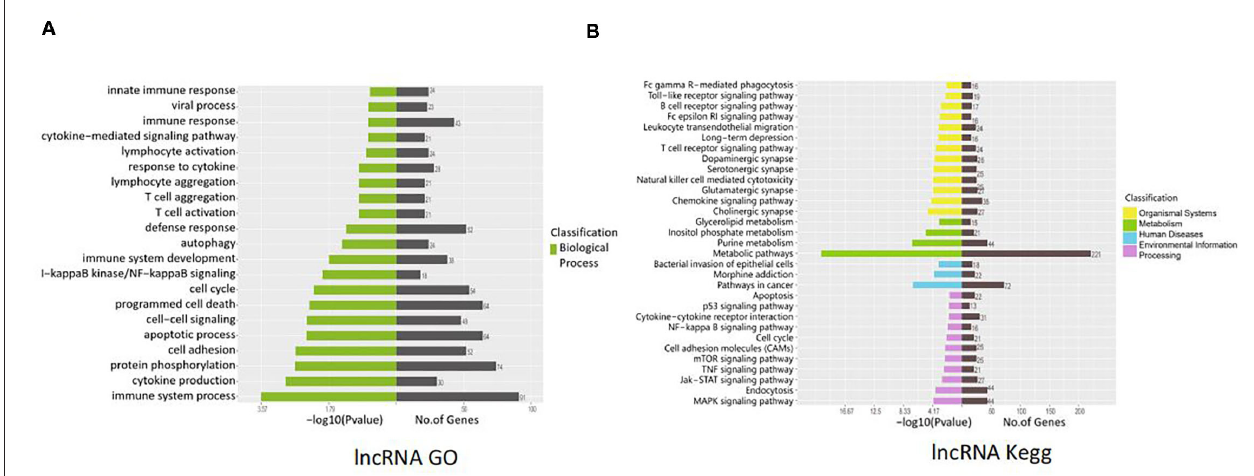
FIGURE 4 | Functional prediction of SVV-induced new lncRNAs. (A) Gene Ontology (GO) analysis of the functional annotation of differentially expressed new lncRNAs. (B) KEGG pathway analysis of the functional annotation of differentially expressed new lncRNAs.